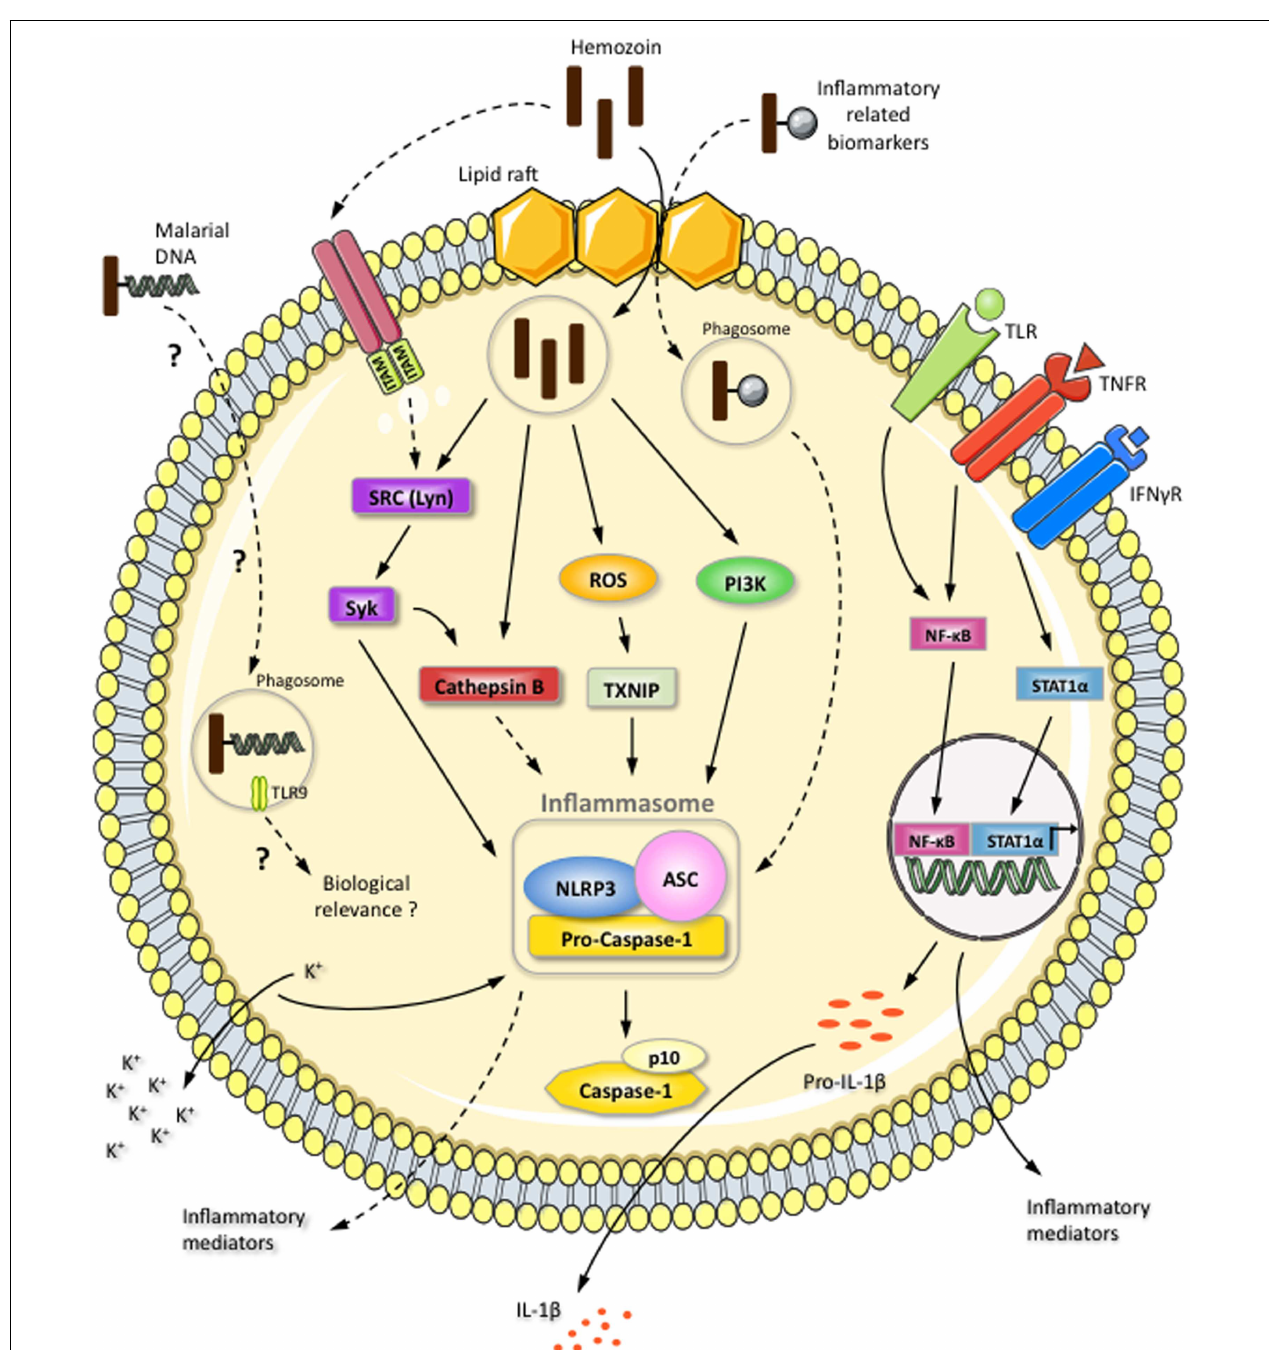
modulates cathepsin B activation, which could result in the induction of the NLRP3 inflammasome. HZ is also capable of activating the NLRP3 inflammasome through PI3 kinase.The involvement of malarial DNA, which can adhere to HZ, in the activation of an intracellular receptor and its biological relevance are controversial and only reported for dendritic cells, which are present in limited numbers in the blood. HZ can interact with a large number of inflammatory-related biomarkers found in the circulation of P. falciparum -infected patients. However, the effect of these biomarkers on NLRP3 inflammasome activation is still unknown. Continuous arrows indicate a positive modulation. Dotted arrows indicate a hypothetical effect. Dotted arrows with a question mark indicate an unknown or controversial